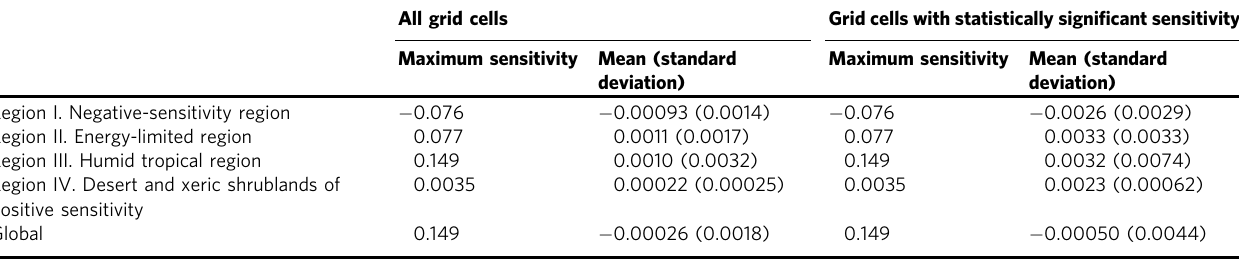
Table 1 Summary of ecosystem sensitivity to climate water de fi cit (CWD) between 1982 and 2013 in different regions globally.